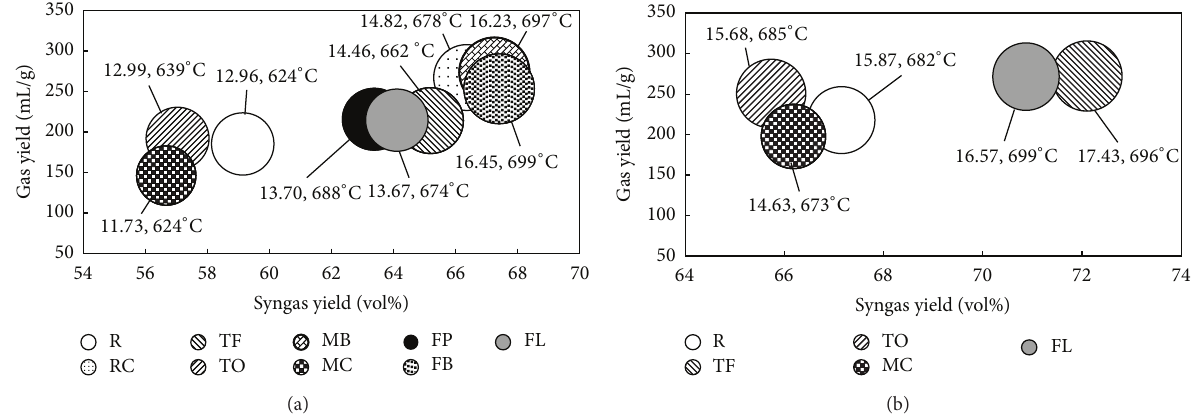
Figure 8: HHVs of pyrolysis gas with respect to its yield and syngas yield: (a) H 2 /CO = 2 and (b) H 2 /CO =